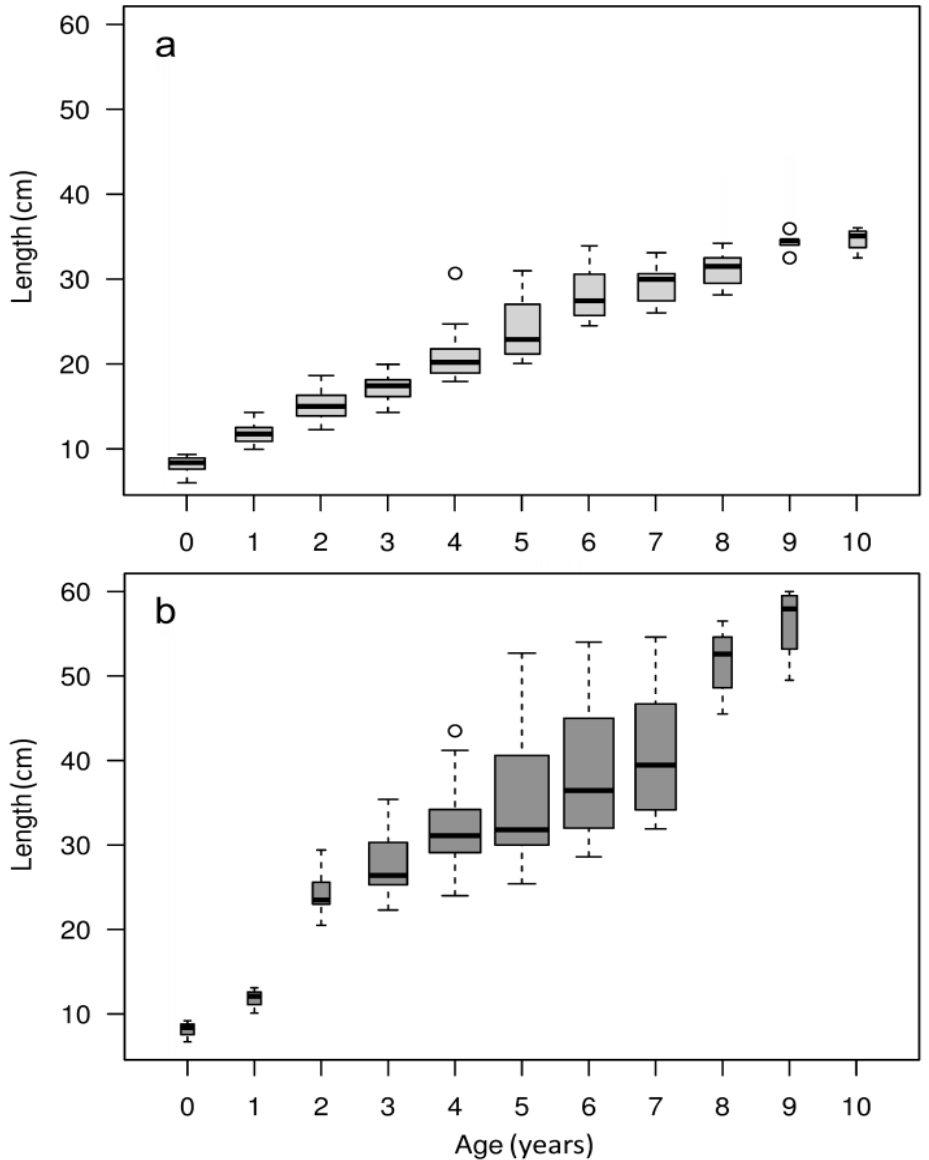
Figure 4. Boxplot of age-at-length data for eels collected in the ( a ) tributaries and ( b ) estuary. Thicker boxes indicate a higher number of eels for the corresponding age class. Shape Indicies (SI) and Elliptic Fourier Descriptors (EFD) values and variable individual results are in Tables S1 and S2, respectively. In the tributaries, otolith shape differed between a few locations in the tributaries: Coura from Insuas and Lajes, Mouro from Insuas and Gadanha, and S.Gonçalo from Lajes (MANOVA, Pillai´s Trace, F 1.6049 = 0.999, p < 0.05). The LDA, through the Jackknife reclassification matrix, showed that Lajes was the site with the best reclassification value (40%), but the overall reclassification success was low (26%; Table 3. The lack of specific groups can be visualized in the CVA plot (Figure 5a). Vectors’ overlay shows the RO as the most prominent variable for group characterization. The otolith shape of eels collected in the brackish sampling location (Caminha) was different from those collected in the TFW (MANOVA, Pillai´s Trace, F 1.799 = 0.589, p < 0.05). The LDA, through the Jackknife reclassification matrix, showed good reclassification success for Caminha (57%), but an overall poor reclassification success for the eels collected in the estuary (34%; Table 3). The discrimination of Caminha can be visualized in the CVA plot, where vector overlays show the prevalence of the otolith outline EFD variables d1, b2, and b3 (Figure 5b). Otolith shape proved to be successful in differentiating eels from tributary vs. estuary habitats (MANOVA, Pillai´s Trace, F 83.883 = 0.842, p < 0.05). The LDA, through the Jackknife reclassification matrix, showed an overall reclassification success of 98%, with complete reclassification success for the tributary habitat (100%; Table 3). The discrimination of both habitats can be visualized in the CVA plot (Figure 5c). Additionally, the CVA plot of the undifferentiated eels shows similar results (Figure 5d). Vector overlays show that the SI variables RO and CI describe the otoliths of the individuals collected in the tributaries, whereas EL and RE describe the otoliths of the individuals collected in the estuary. Otolith outline EFD variables d1, b2, c2, b4, d3, d4, and b3 also contribute to the discrimination between groups.